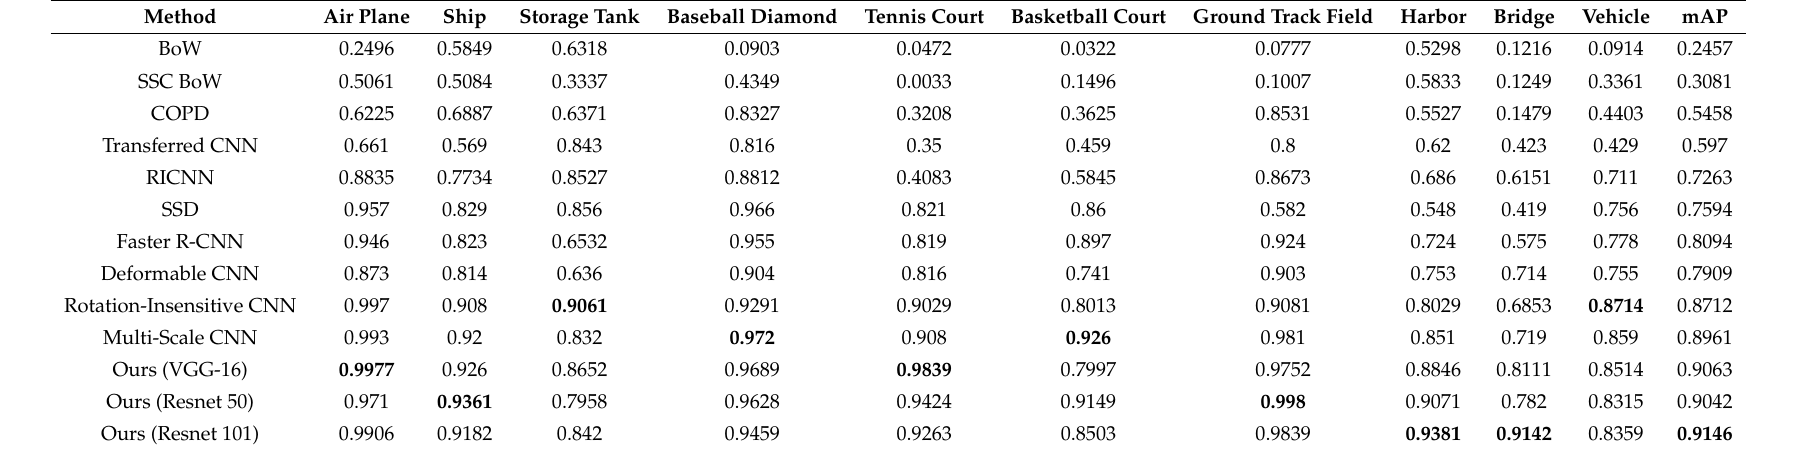
Table 2. Performance Comparison between the proposed model and the state-of-the-art models on NWPU VHR-10